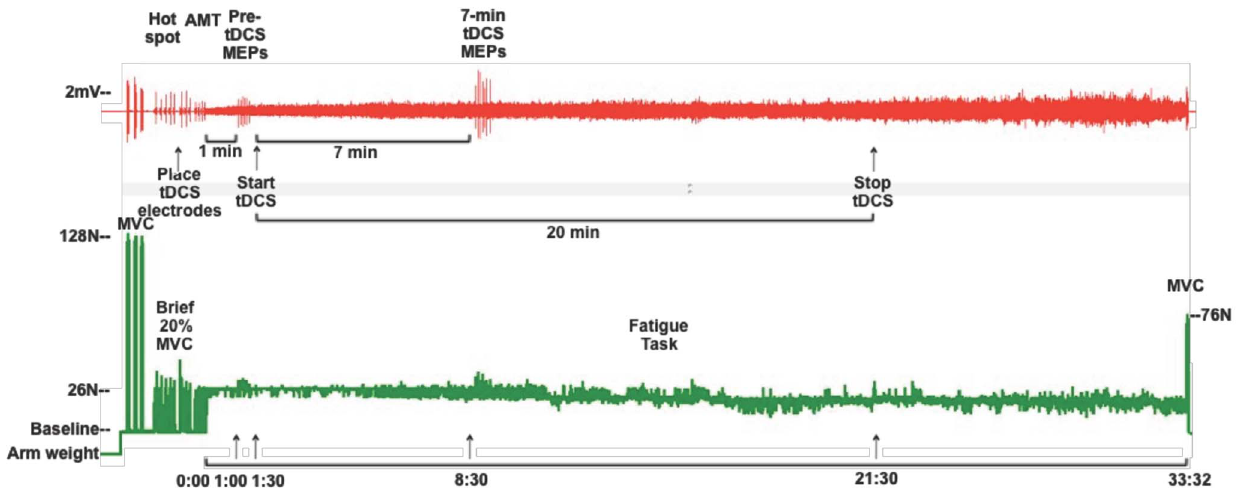
Figure 1. Experimental protocol. ( Top ) Representative traces of biceps electromyogram (EMG) and (Bottom) force signal from one subject during anodal tDCS. Resting arm weight was measured and added as a constant to the force signal to create a 0.0N baseline with the arm relaxed. Three elbow flexion maximum voluntary contractions (MVCs) were followed by a series of brief (3–5 sec) 20%MVC contractions during which motor evoked potentials (MEPs) were measured in the biceps EMG. After locating the biceps motor hotspot, but prior to determining active motor threshold (AMT), the transcranial direct current (tDCS) electrodes were placed on the scalp. One minute after starting the fatigue task, 6 MEPs were evoked over 30 seconds (Pre-tDCS MEPs), immediately after which the anodal tDCS was initiated (at time 1:30). The second set of 6 MEPs were evoked at time 8:30 of the fatigue task which was after 7 minutes of tDCS (7-min tDCS MEPs). At time 21:30 of the fatigue task, the tDCS stimulation was terminated as the maximum duration for the tDCS protocol was 20 minutes. This subject’s time to task failure was 33:32 minutes. At task failure, one final MVC was performed prior to relaxing.